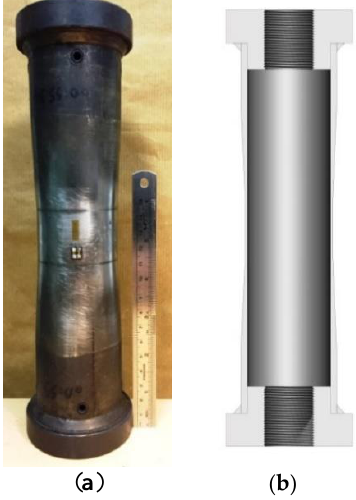
Figure 2. Monotonic uniaxial test sample: ( a ) external view ( b ) internal view.